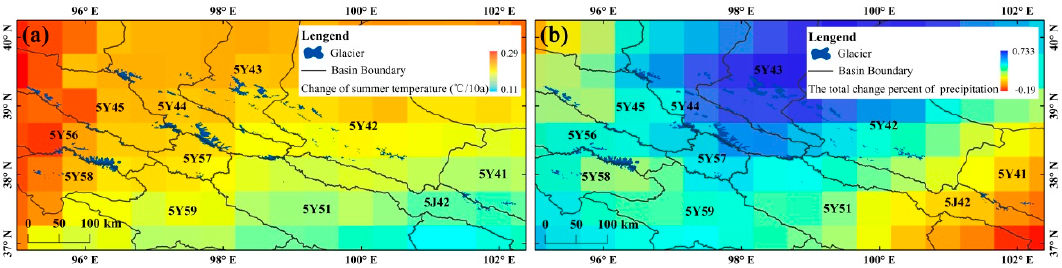
Figure 13. Changes in summer temperature ( a ) and total change percent in annual precipitation ( b ) from 1960 to 2015.